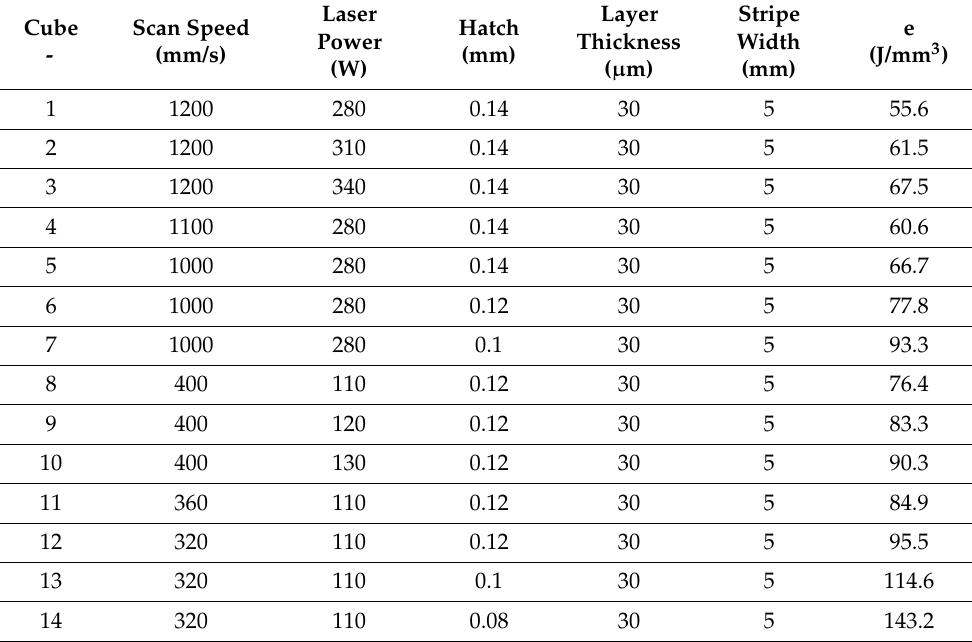
Table 1. Process parameters design of